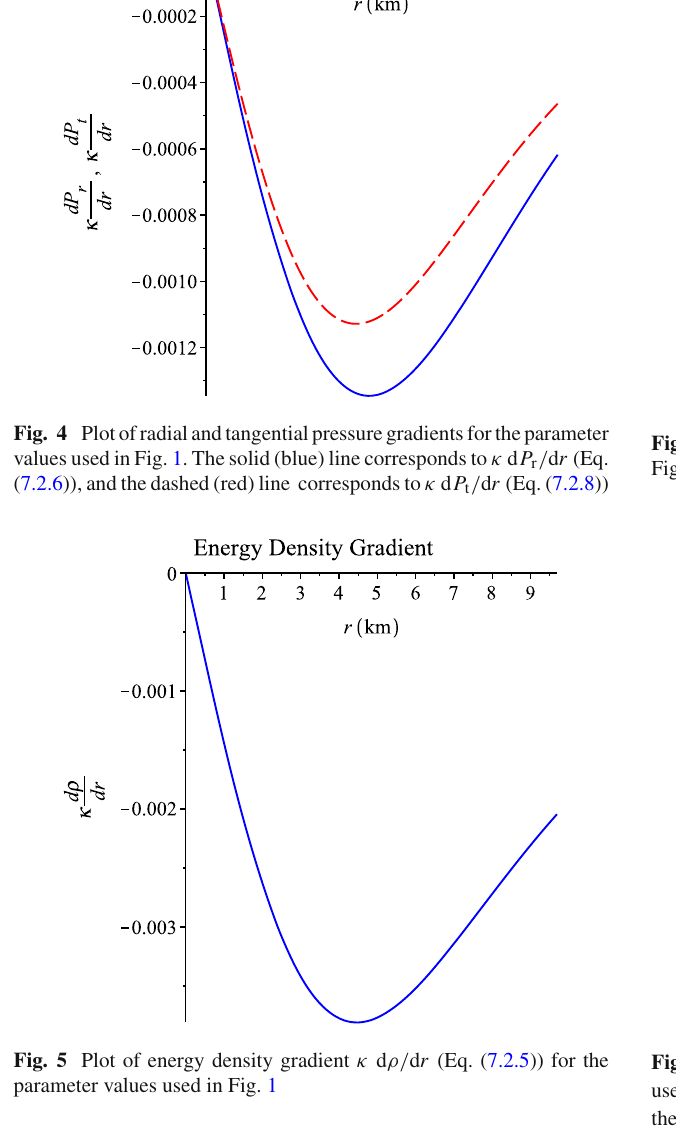
bution and hence P r , P t , ρ are monotonically